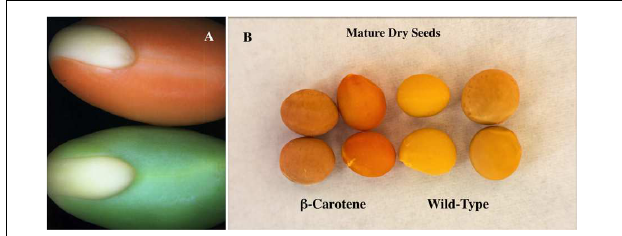
FIGURE 2 | β -carotene biofortified transgenic soybean seeds. (A) developing soybean cotyledons from (bottom) non-transgenic soybean compared to (top) chloroplast localized seed specific bacterial phytoene synthase transgenic soybean. ( B ; column 4) dry non-transgenic soybean seeds, (column 3) dry non-transgenic soybean seeds without seed coat, (column 2) dry transgenic soybean seeds without seed coat and (column 1) dry transgenic β -carotene soybean seeds. Enhanced β -carotene accumulation in transgenic soybean seeds provides a visually obvious orange color in both developing cotyledons and dry